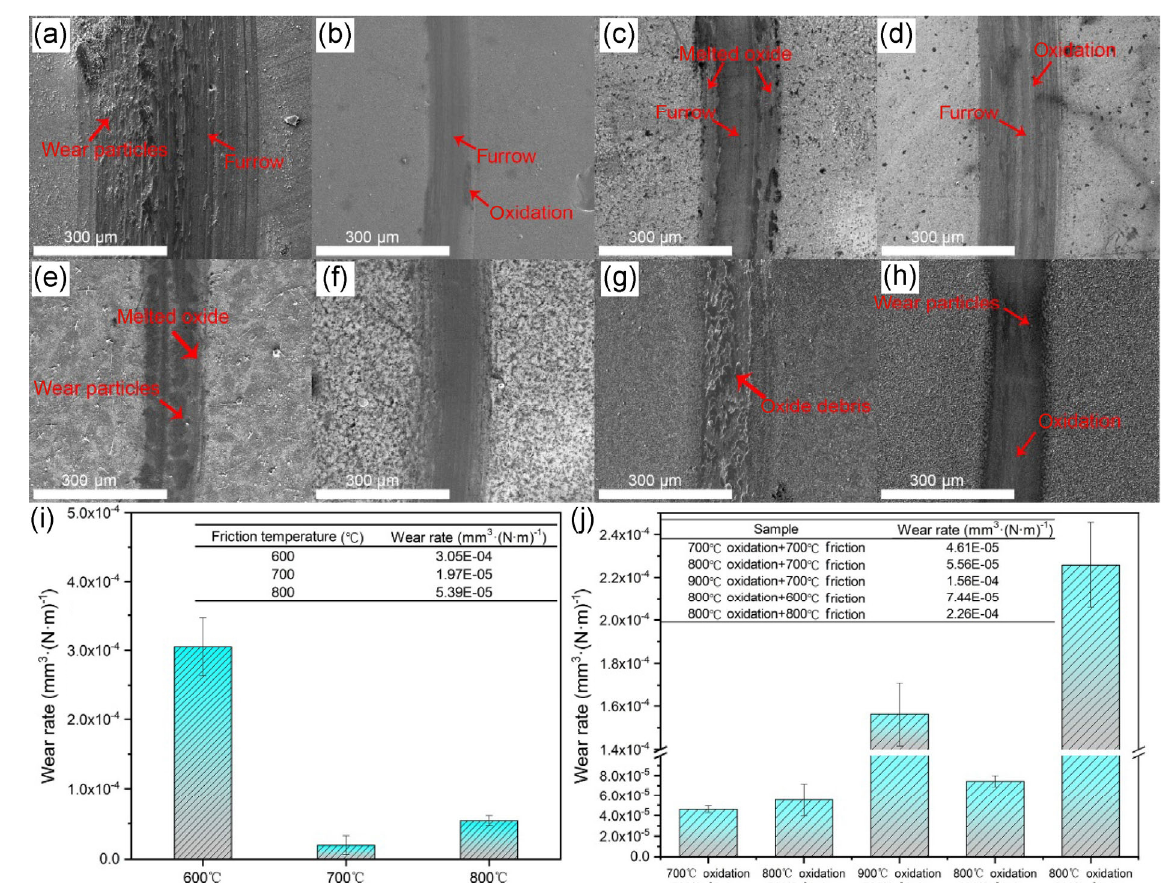
Fig. 3 SEM micrographs of wear tracks of the as-prepared films after friction at 600, 700, and 800 °C (a)–(c). Wear tracks of the films pre-oxidized at 700, 800, and 900 °C followed by friction at 700°C (d)–(f). Wear tracks of the films pre-oxidized at 800 °C followed by friction at 600 and 800 °C (g)–(h). Wear rate of the as-prepared films (i) and the pre-oxidized films